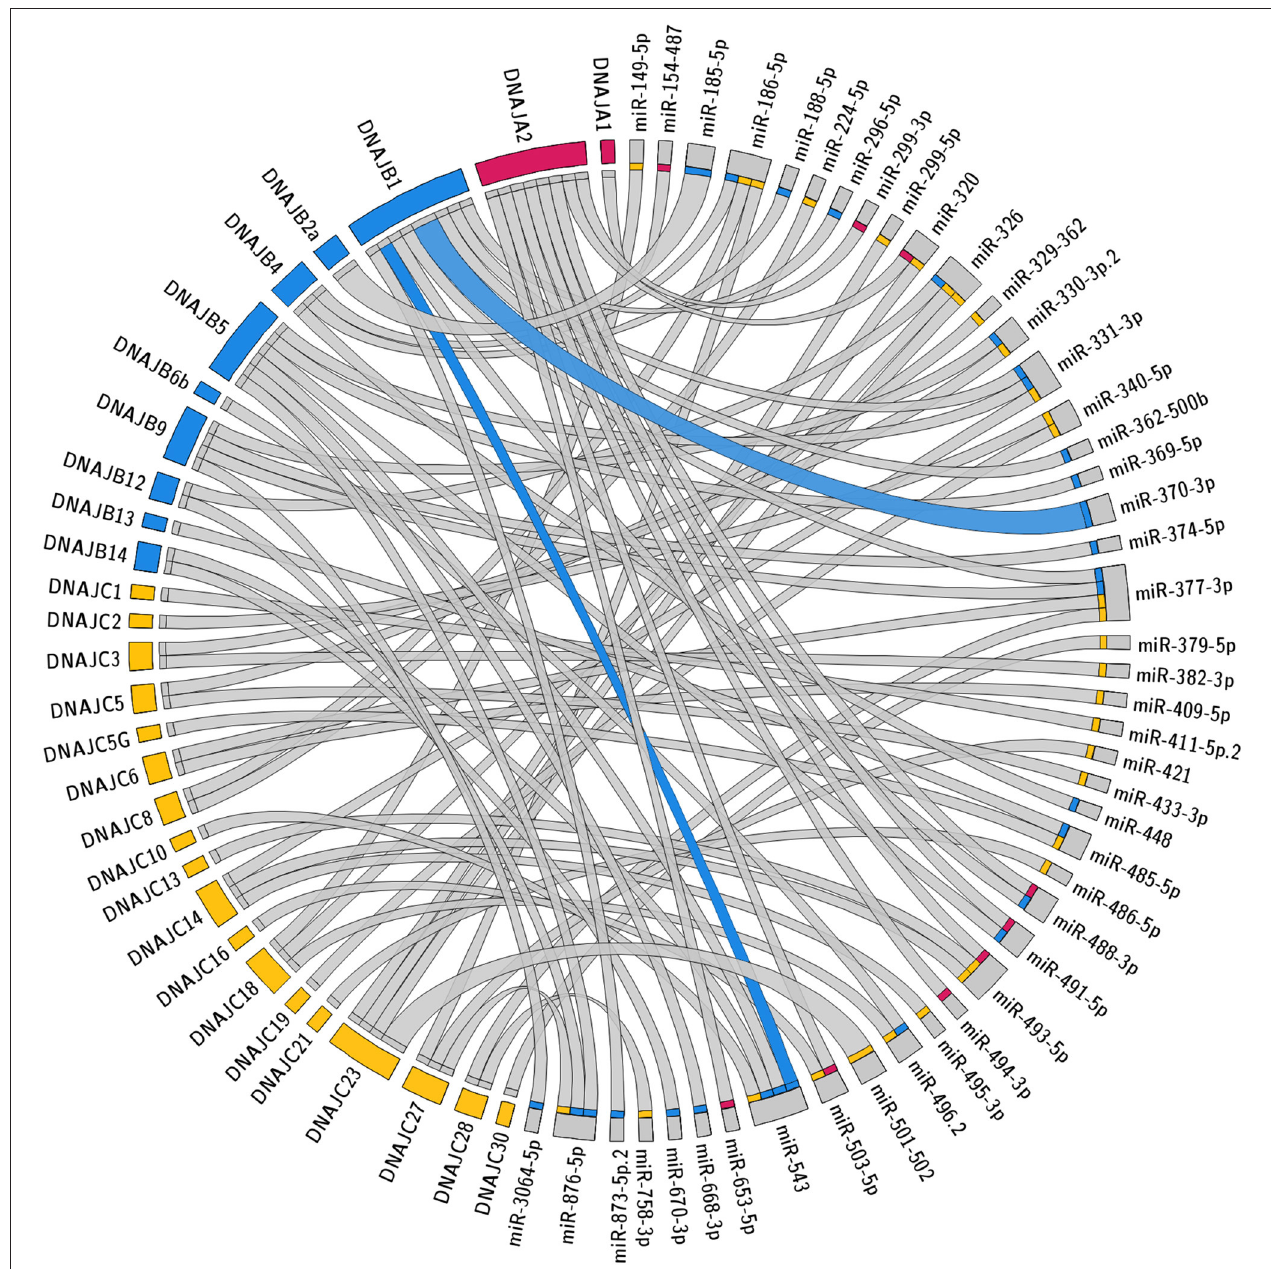
FIGURE 3 | Predicted miRNA targets for miRNAs conserved within mammals. Interaction Circos plot (Krzywinski et al., 2009) for TargetScan depicting miRNA targeting of the J-Protein by miRNA families that are conserved throughout mammals. For each J-Protein, miRNAs with a context score of < − 0.1 were extracted from TargerScan (Agarwal et al., 2015). Unconserved target sequences for miRNAs that were not conserved were excluded from the analysis. A colorized line indicates miRNA targeting that has been experimentally verified and the width of the bridging lines is proportional to the number of predicted target sequences.